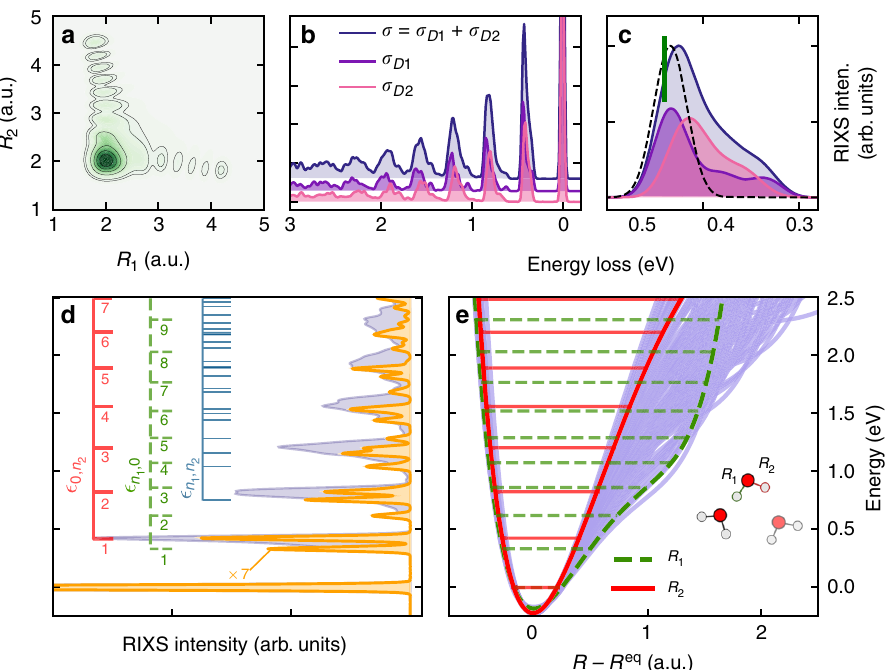
Fig. 3 Role of coherent excitation of both OH bonds. a The nuclear core-excited wave packet squared shows coherent excitation of both OH bonds in a D2 con fi guration. b Partial resonant inelastic X-ray scattering (RIXS) cross-sections σ D1 and σ D2 . c Partial contributions to the RIXS peak m = 1. The dashed curve shows the result from the single bond approximation σ sb simulated including only the single OH stretches with a broken HB. The vertical green bar D1 shows the theoretical peak position of the RIXS in gas-phase water. Current DFT (BLYP) description gives a slight red-shift of the peaks relative to experiment and to high-level calculations 17 – 19 . d Total RIXS pro fi le (blue) and assignment of RIXS spectrum (yellow) of a single asymmetric D1 structure. e All OH potentials (blue) of the sampled con fi gurations. Solid red and dashed green curves show the steep (no HB) and shallow (HB) OH potentials of the D1 structure in d . Subsets of eigenvalues ϵ n (solid red) and ϵ 0 ; n (dashed green) in d , e assign the single bond excitations associated with potentials of 1 ; 0 2 corresponding colour while the subset ϵ n (blue) displays the mixed excitation 1 ; n 2